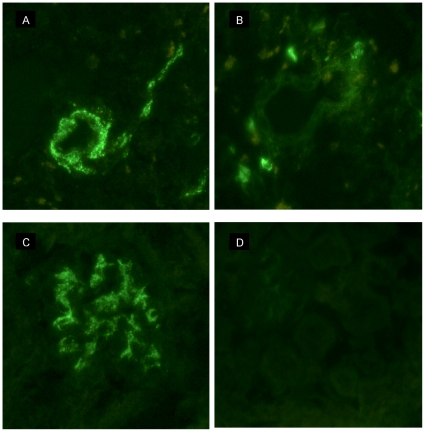
Tissue IgG1 immune complex deposits.Direct immunofluorescence using FITC-conjugated anti-IgG1 antibodies on cryostate sections from female BALB/c wild type (A, C) and FcRγ−/− (B, D) mice treated with 15 mg/l HgCl2 in the drinking water for 5 weeks. Heavy granular staining in splenic vessel walls (A) and renal mesangium (C) in wild type mice, but only slight deposits in the corresponding tissues of FcRγ−/− mice (B, D).